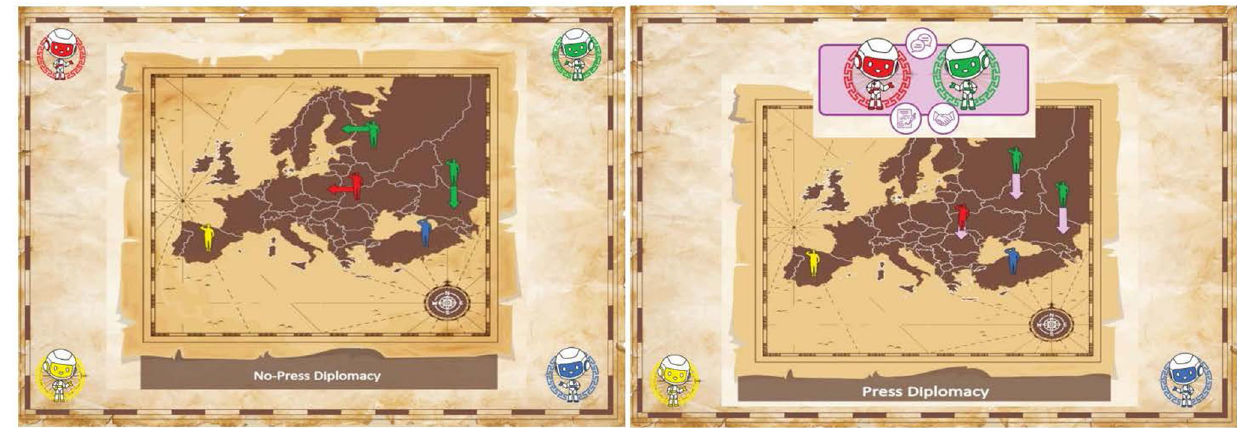
Fig. 1 | Contrasting No-Press Diplomacy and Press Diplomacy. Left: In No-Press Diplomacy, players may not directly communicate to coordinate a joint plan. AI agents each select actions on their own. Right: In Press Diplomacy players directly communicate with each other to decide on a joint course of action. Agent algo- rithms determine how they agree on a joint plan. We express such plans using a contractregardingfutureactions.ThemovephaseisidenticalinPressandNo-Press Diplomacy, and the next board state depends only on the actions chosen by the